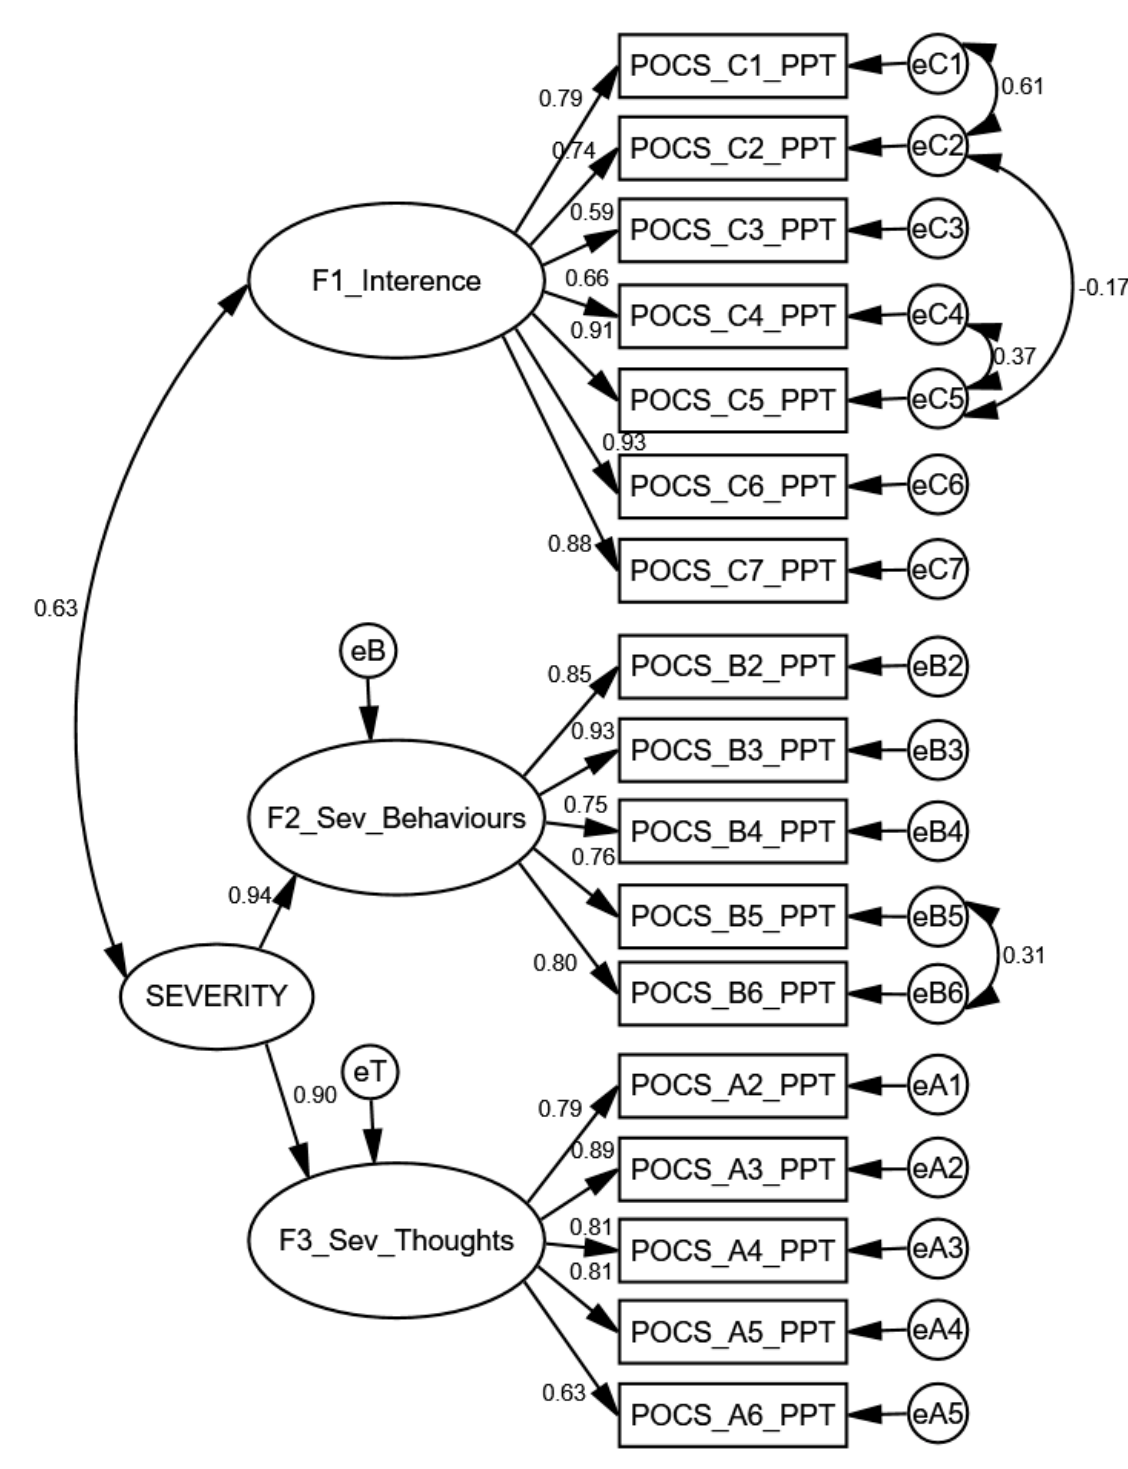
Figure 1. Final model of the POCS with standardized parameter estimates. Spearman correlations between factors are presented in Table 1. Table 1. Spearman coefficient correlations between POCS factors.